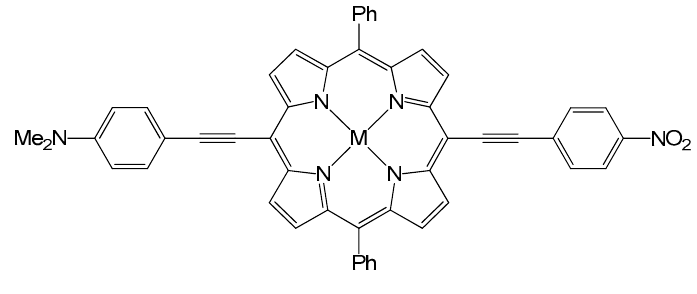
Figure 1. M = Ni ( 1 ), Cu ( 2 ), Zn ( 3 ).